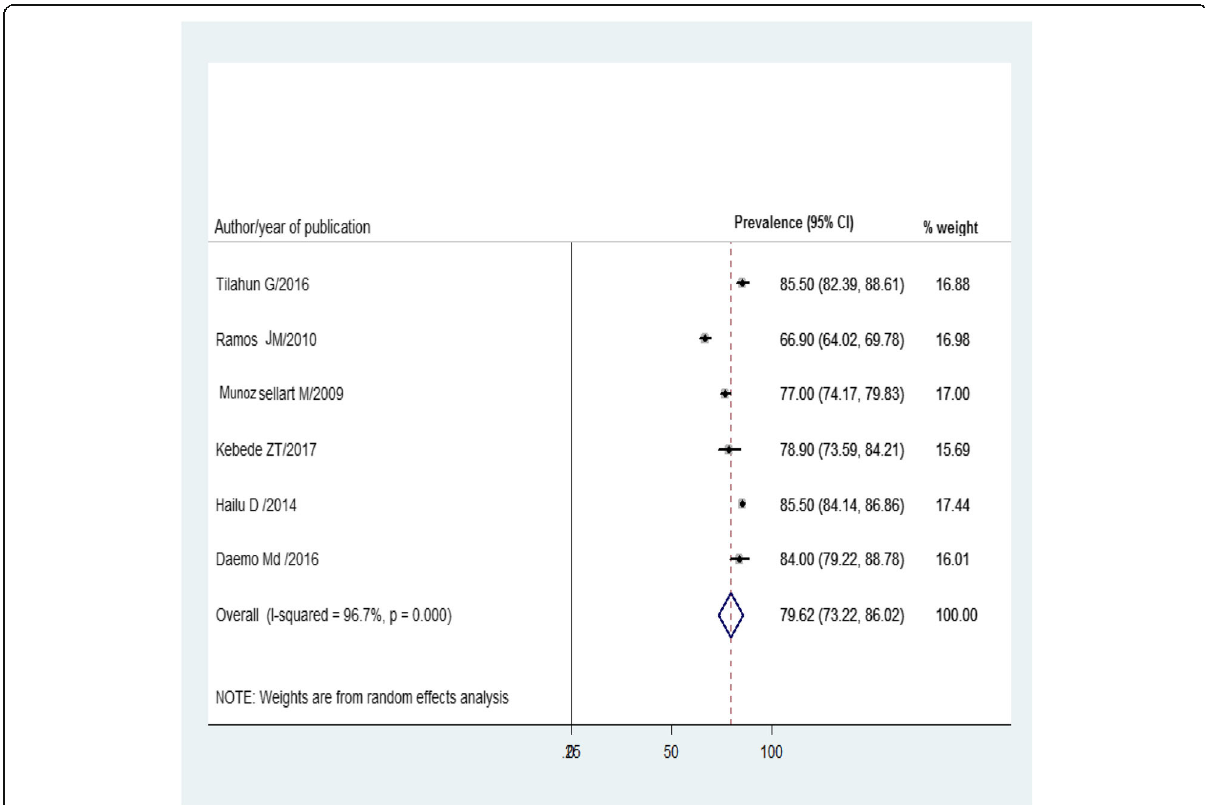
Fig. 3 Forest plot of successful childhood TB treatment outcome